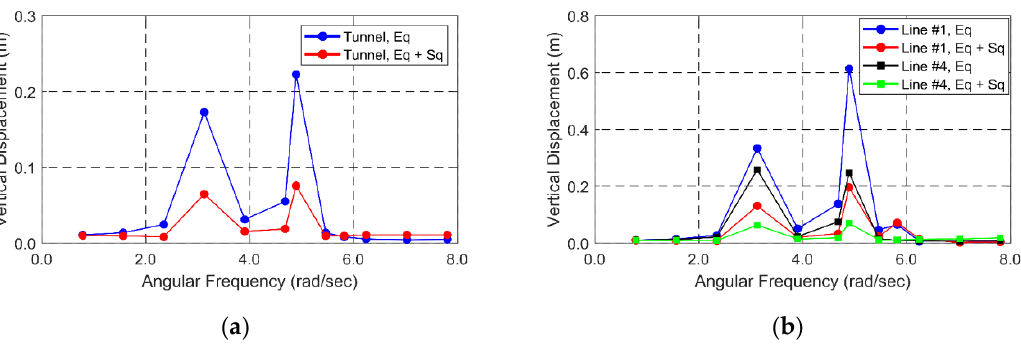
Figure 10. Amplitudes of vertical displacements of the tunnel ( a ) and mooring line #1 ( b ) at the middle location under regular seismic excitations of various frequencies (Eq: earthquake only considered; Eq + Sq: both earthquake and seaquake considered).